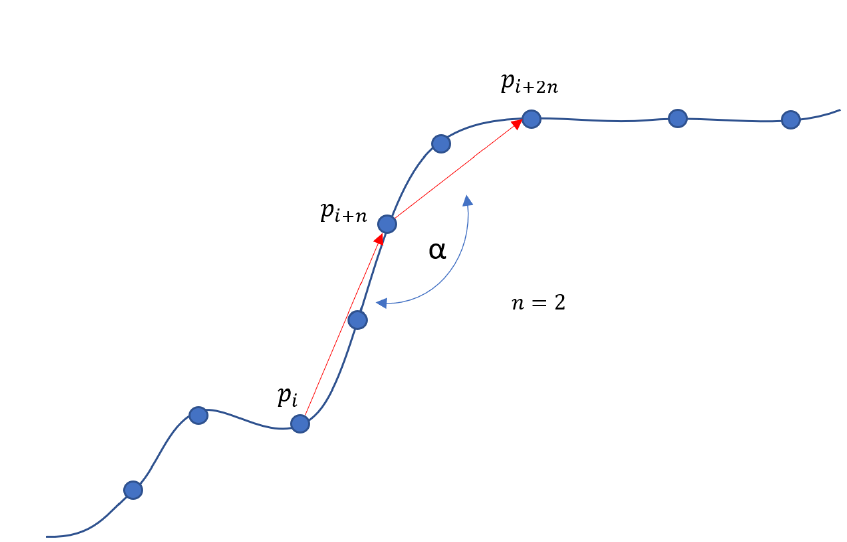
Figure 6. The method used to calculate the one-dimensional array of angles from the series of points in space. 3D path to angle